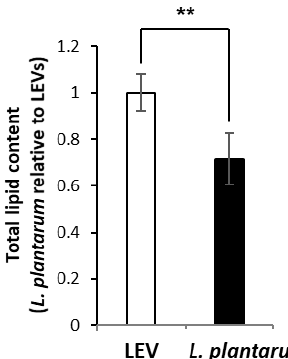
Figure 3. Relative expression of total lipids in LEVs and L. plantarum . The expression levels of total lipids were determined by summing the amounts of identified lipid species in LEVs and L. plantarum , respectively. The value of fold change is shown as mean ± S.D. ( n = 9 per group; three independent biological replicates and three technical replicates). Statistical significance was analyzed by Student’s t -tests for two groups (** p < 0.01). Table 2. Summary for the fold change of lipid classes in LEVs relative to L. plantarum . The value of fold change is shown as mean ± S.D. ( n = 9 per group; three independent biological replicates and three technical replicates). Lipid classes increased more than two fold in LEVs or the parent cells were highlighted in light or dark gray, respectively. Statistical significance was analyzed by Student’s t - tests for two groups.